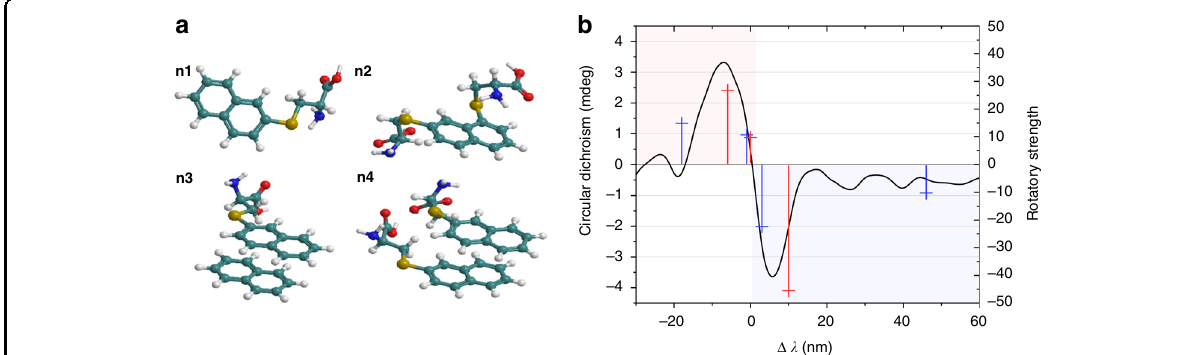
Fig. 6 Theoretical modeling of the optical response for CD-cys . a Illustration of surface-located chiral optical centers of CDs based on a naphthol molecule with one (n1) or two (n2) L -cysteine molecules and a naphthol dimer with one (n3) or two (n4) L -cysteine molecules. These four models have been used to demonstrate the possible chiral features of CD-cys in the longer-wavelength region 300 – 400 nm. b Comparison of the calculated rotary strength for n3 (red crosses) and n4 (blue crosses) and the measured circular dichroism spectrum for CD-cys at the wavelength scale relative to the maximum absorption bands at 309, 318, and 340 nm for (n3), (n4), and CD-cys . In ( b ), positive second Cotton and negative fi rst Cotton effects are highlighted by red and blue rectangles,